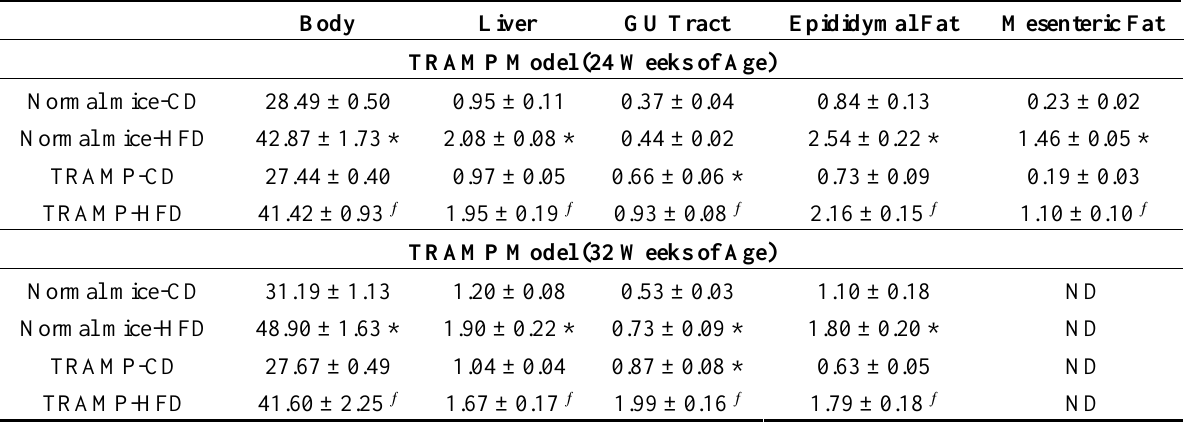
Table 3. The body weights and organ weights (g) of TRAMP mice and their normal littermate controls. Body Liver GU Tract Epididymal Fat Mesenteric Fat